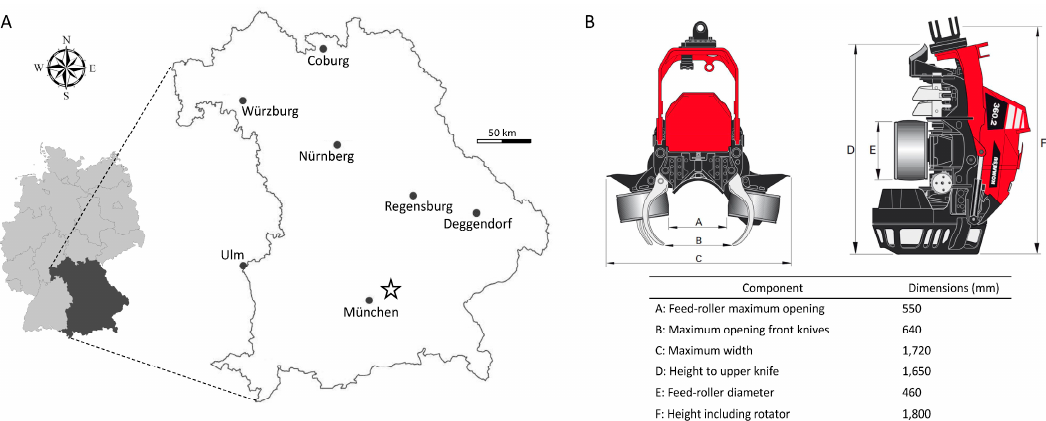
Figure 1. ( A ). Location of research sites depicted by star symbol within the State of Bavaria, Germany; ( B ). Top and side-view of a Komatsu 360.2 harvesting head along with dimensions of the main components [21].